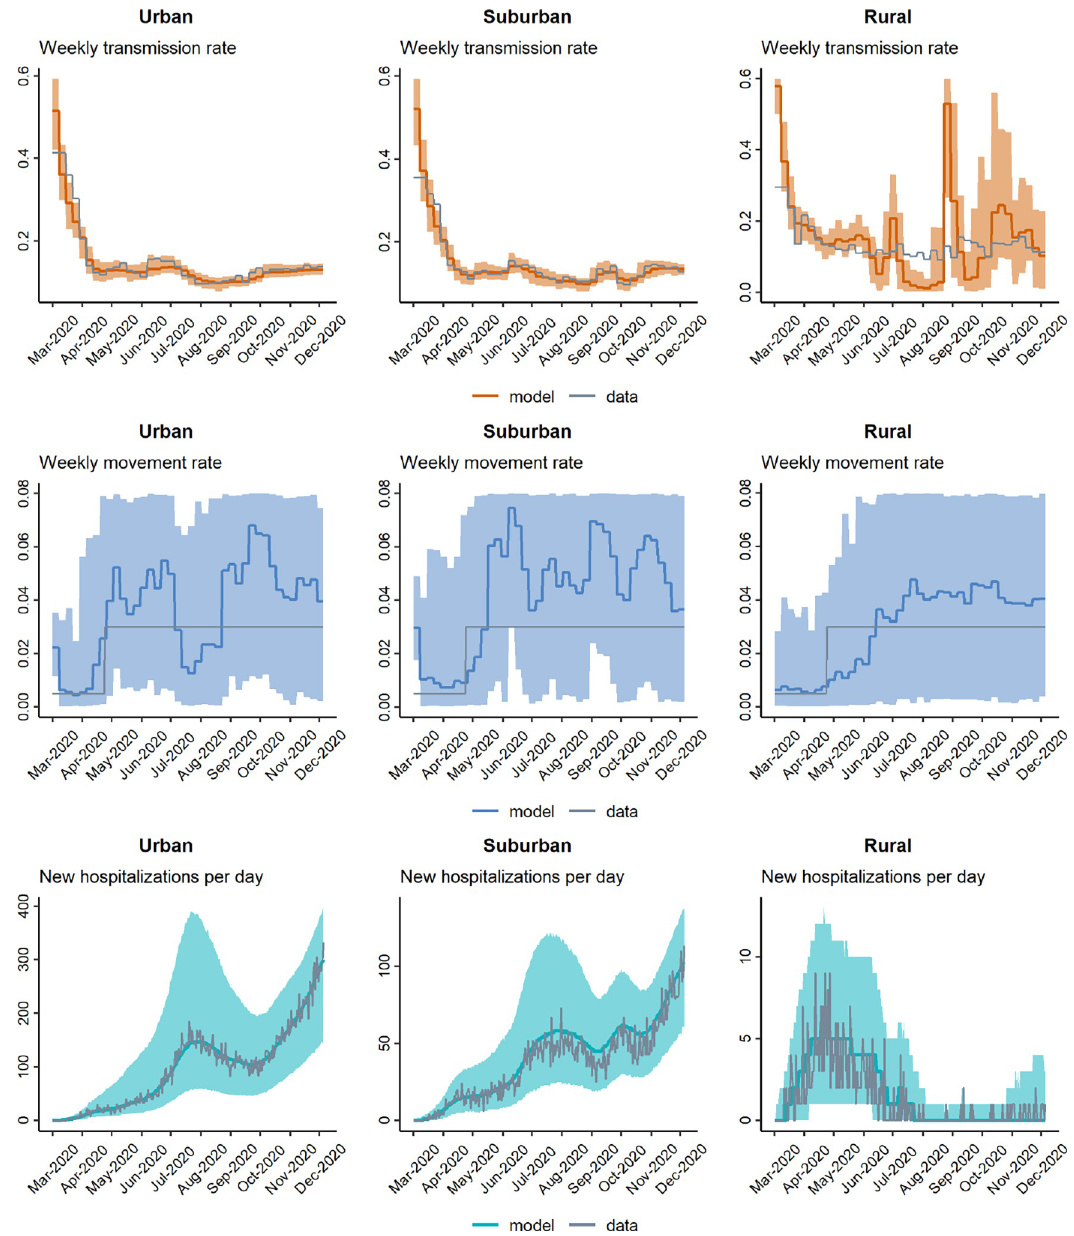
Fig 7. Model-fitting of weekly transmission rate β